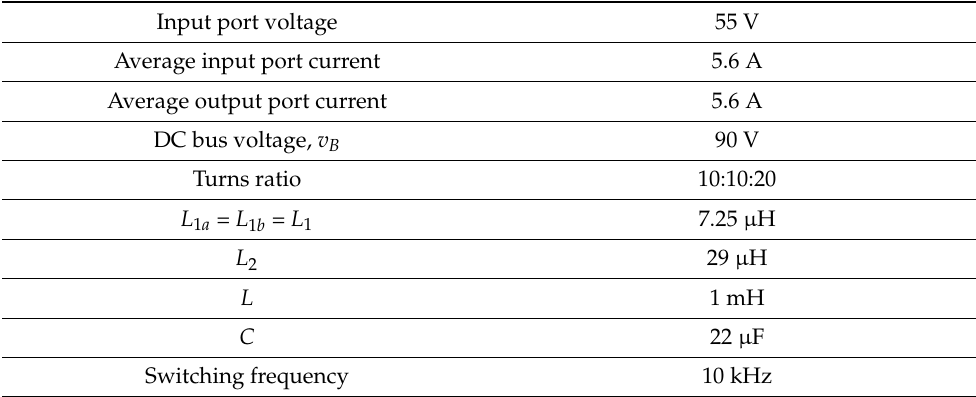
Table 2. The converter